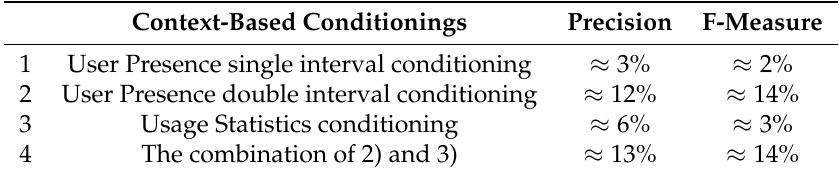
Table 9. Average Precision and F-Measure improvements over the basic AFAMAP algorithm